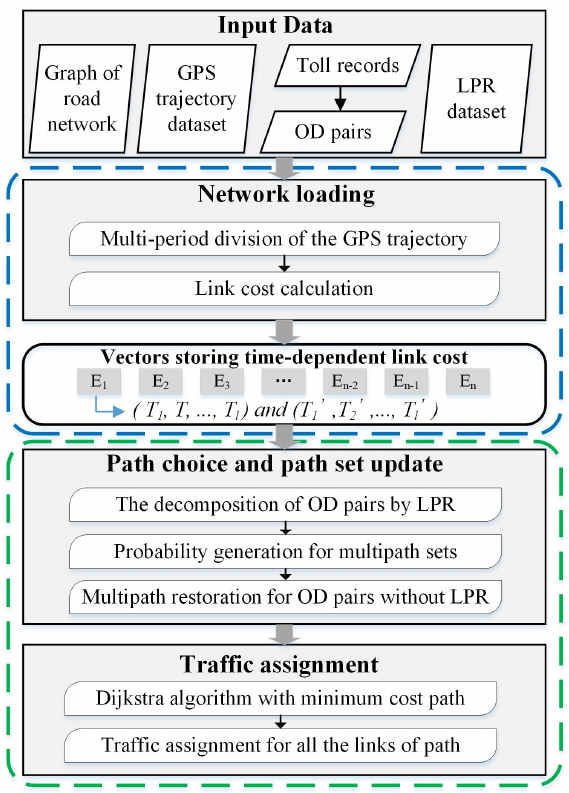
Figure 3. The overall framework of the DQ-DTA model. The modules in the blue and green dashed boxes represent the dynamic link cost calculation (DLC) and multipath assignment based on statistical probability (MSP) methods respectively.